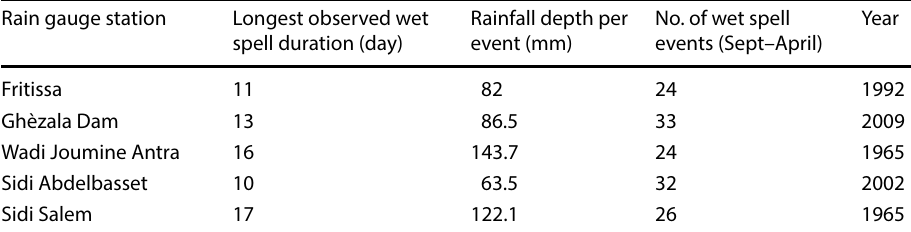
Rain gauge station